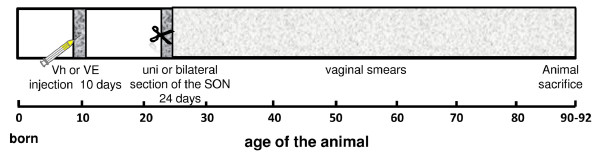
Experimental design.